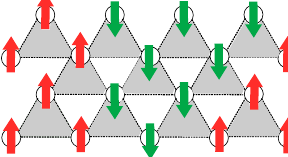
FIG. 9. Example of a classical spin configuration contributing to the operator-spreading coefficients of an initial one-site Pauli operator. All such configurations have a single domain of down spins spreading inside the light cone, and each of these con- figurations contributes equally to j c ν ð t Þj 2